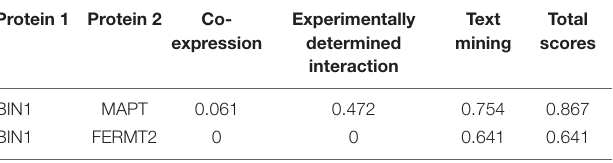
TABLE 4 | Pathway-based SKAT-O test. TABLE 5 | The STRING interaction scores between BIN1 and other proteins.